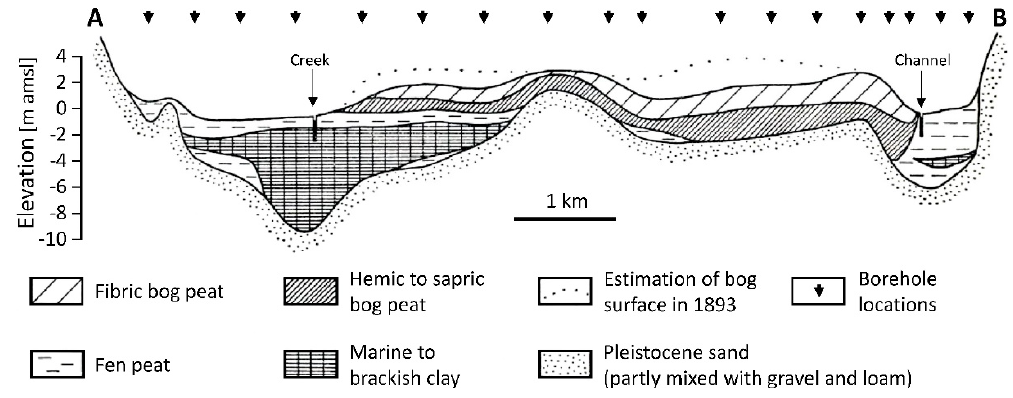
Figure 3. Geological profile A–B of Figure 2 (after [15], legend changed).